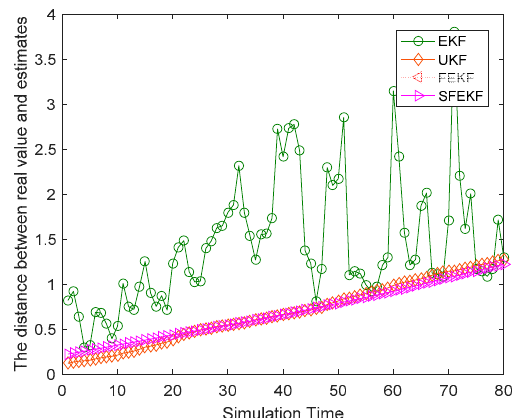
Figure 5. The distance between the real value and estimates for the four methods.